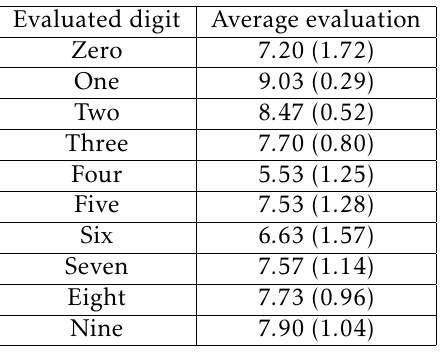
Table 3. Human assessment of results.